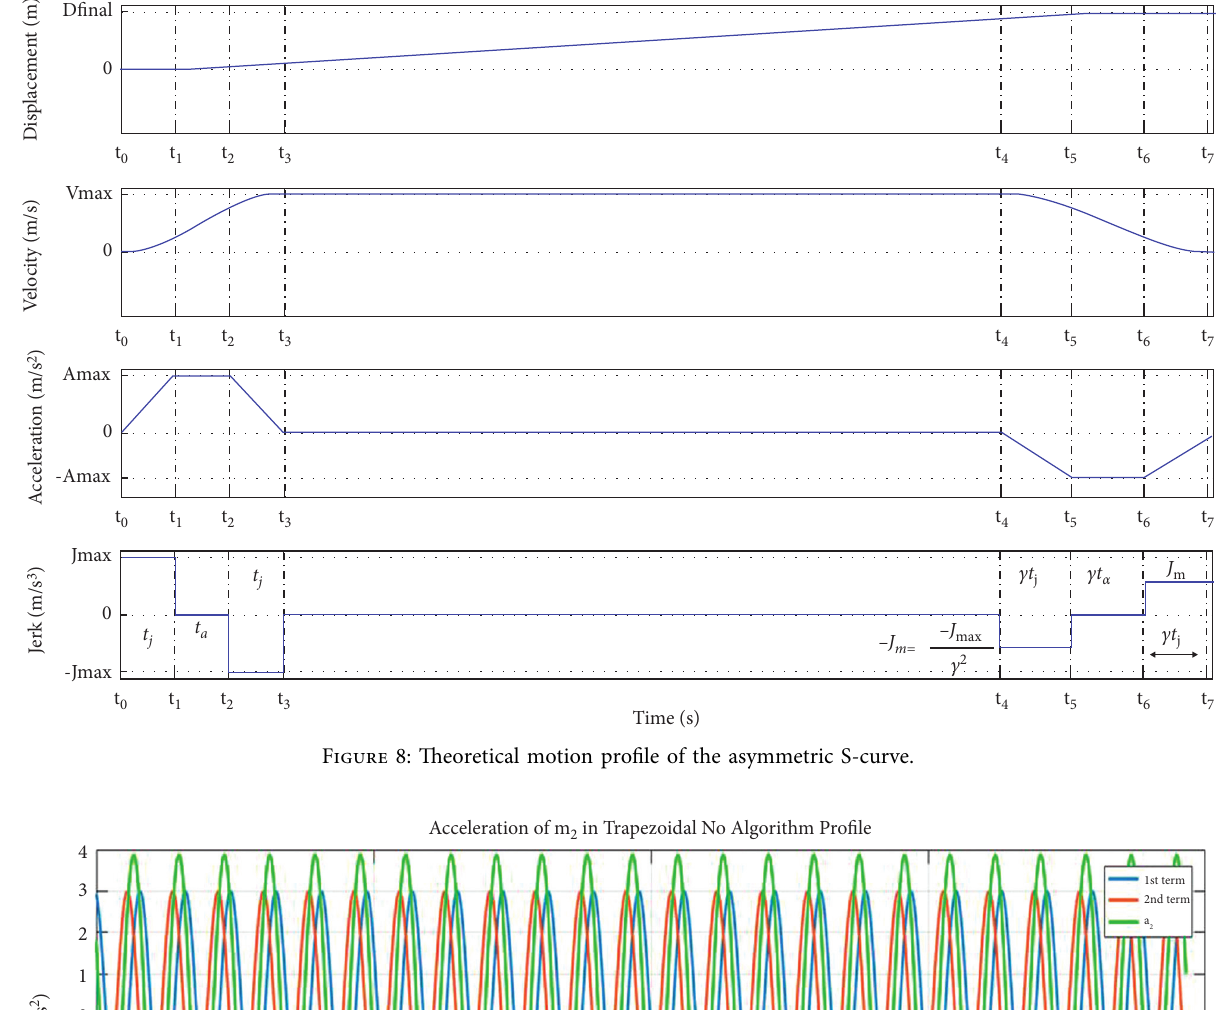
st term, orange: 2 nd